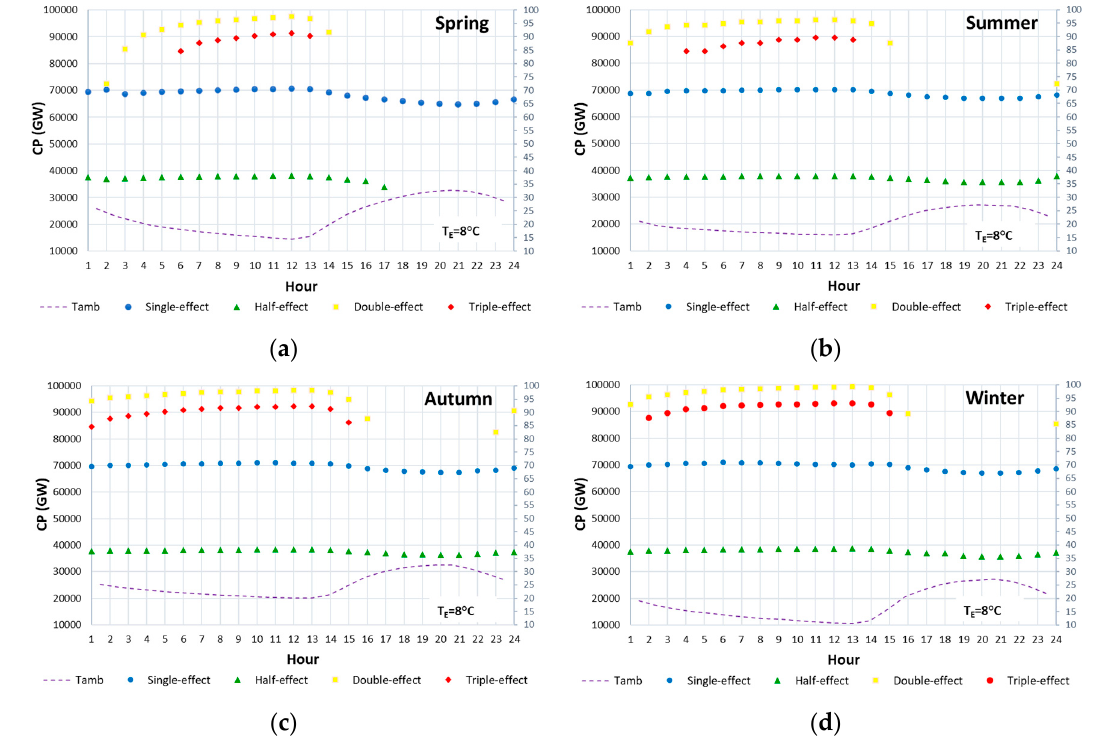
Figure 11. Cooling potential per hour for each absorption system for the season, ( a ) Spring, ( b ) Summer, ( c ) Autumn, and ( d )